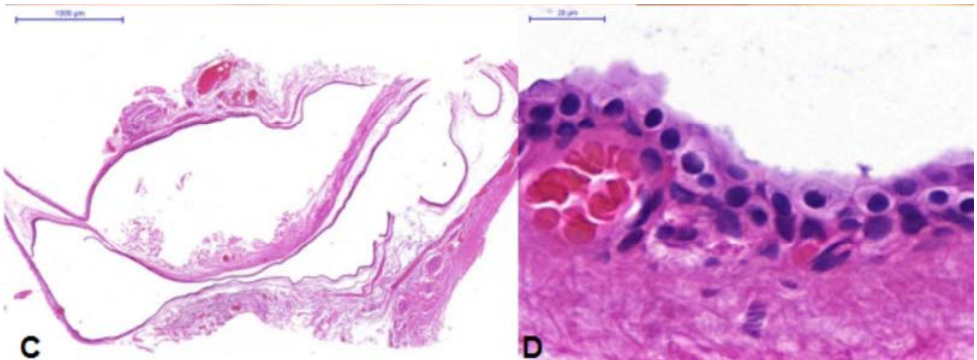
Figure 2. ( A ) Case 2—Ptosis of the right upper eyelid; ( B ) Cystic lesion with clear liquid content among the fibers of the upper eyelid levator muscle; ( C ) Double layered cuboidal cell lining, areas of transitional epithelium and positive apical glycocalyx with apical snouting; ( D ) High power view of lining epithelium consistent with apocrine hidrocystoma showing decapitation